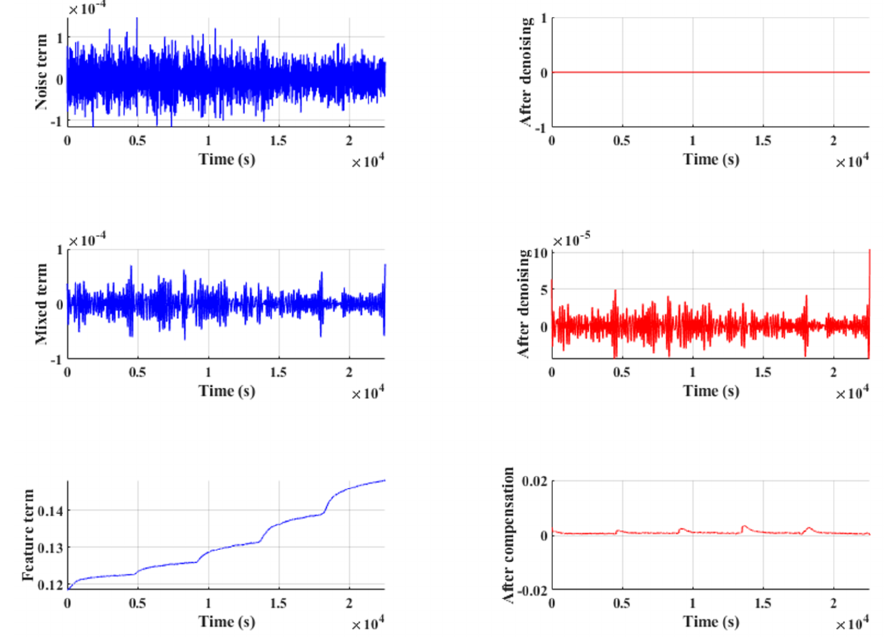
Figure 14. Results of parallel processing by IPSO-VMD and BP-Adaboost model.